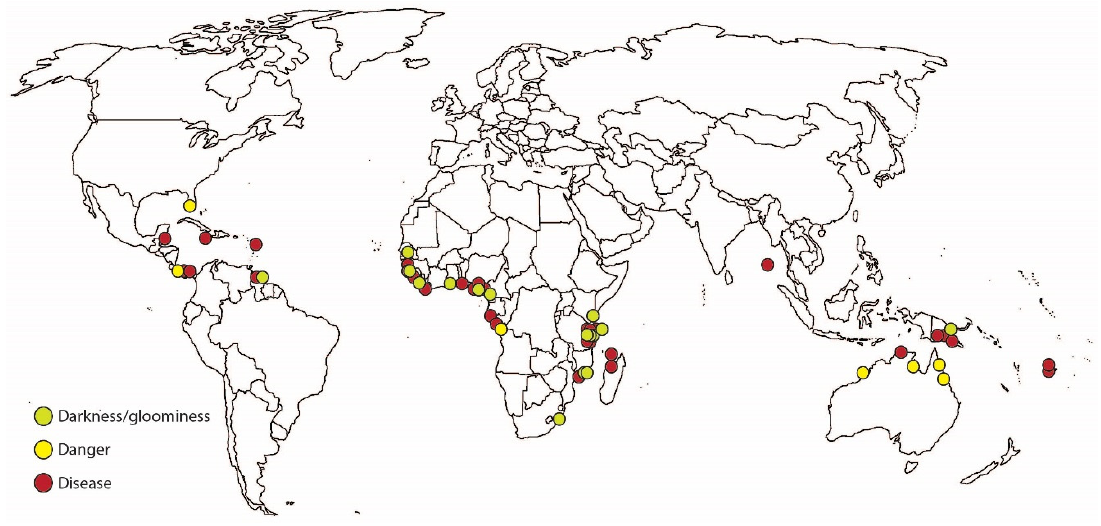
Figure 3. Approximate geographical distribution of historical reports of mangrove ecosystem disservices.